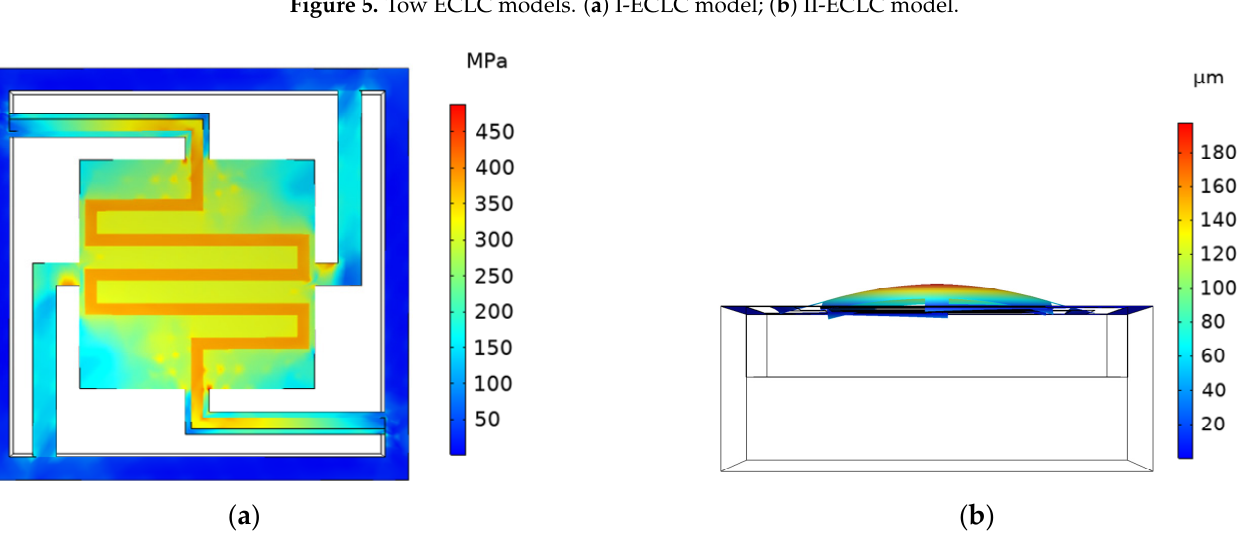
Figure 6. Cloud diagram of stress and deformation displacement simulation of I ‐ ECLC model. ( a ) Cloud diagram of stress simulation; ( b ) cloud diagram of deformation displacement simulation.